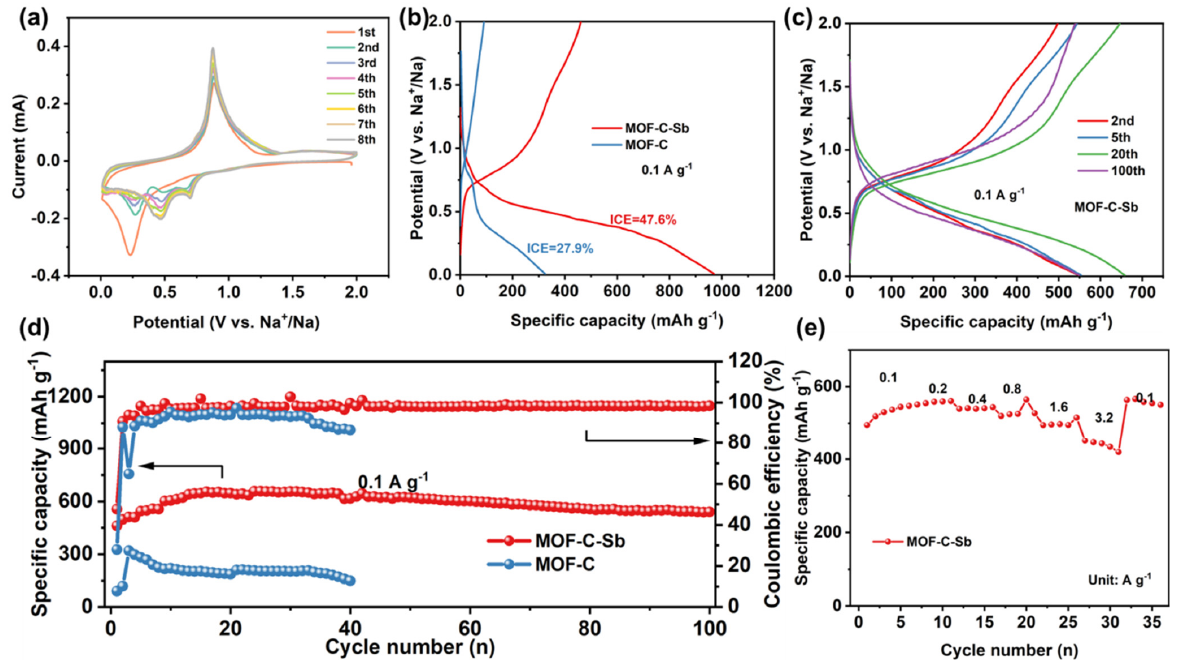
Figure 5. ( a ) CV curves at 0.1 mV s − 1 of MOF ‐ C–Sb electrode. ( b ) The initial GCD profiles of two different electrodes at 0.1 A g − 1 . ( c ) GCD profiles for MOF ‐ C–Sb electrode during various cycles at 0.1 A g − 1 . ( d ) Cycling performance of the two electrodes at 0.1 A g − 1 . ( e ) Rate performance of the two electrodes from 0.1 to 3.2 A g − 1 .